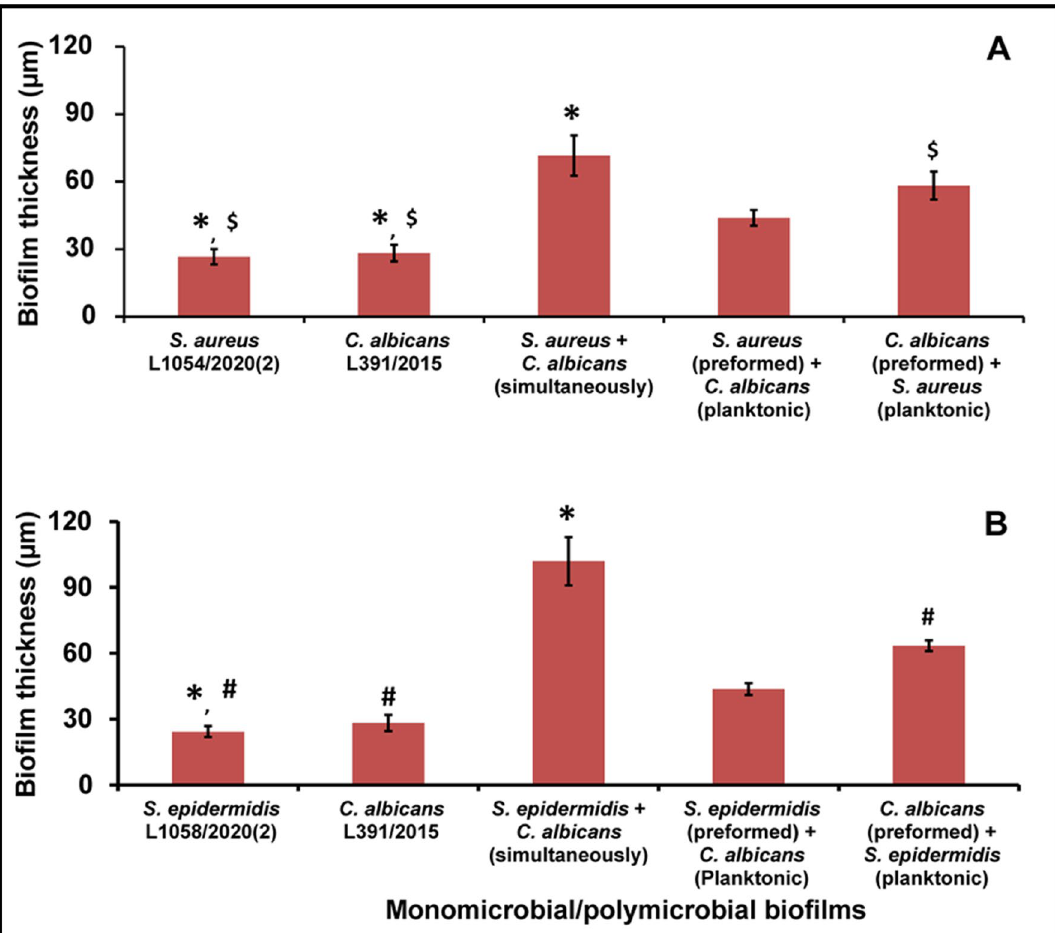
Figure 3. Measurement of polymicrobial biofilm thickness in ocular S. aureus ( A ) S. epidermidis ( B ) and C. albicans ( A , B ) after 48 h of biofilm formation by confocal laser scanning microscopy. Similar superscripts *, # and $ indicate significant increase (p value < 0.05) in polymicrobial biofilm compared to the respective monomicrobial biofilm at 48 h. Unpaired t test was used for the calculation of p value. S. aureus ATCC 25923 was used as a positive control and E. coli ATCC 25922 was used as a negative control. Experiments were performed in triplicates.